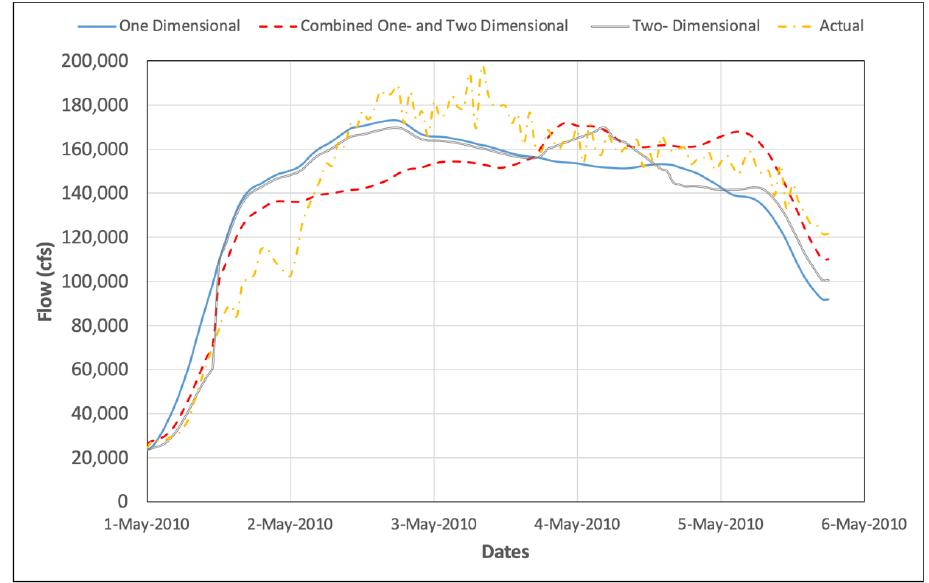
Figure 16. Optimized and actual flows at Nashville during the May 2010 flooding event.